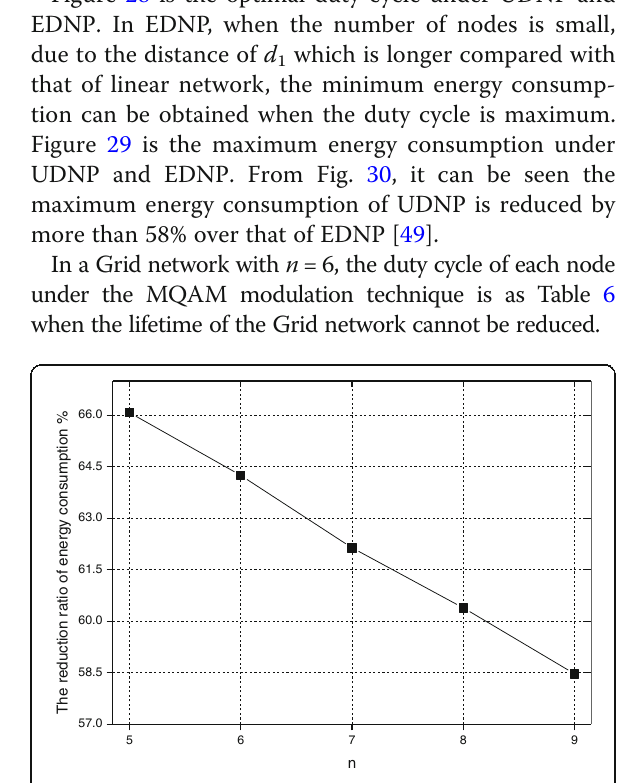
Fig. 37 The maximum energy consumption reduction ratio of UDNP vs EDNP (MPSK)